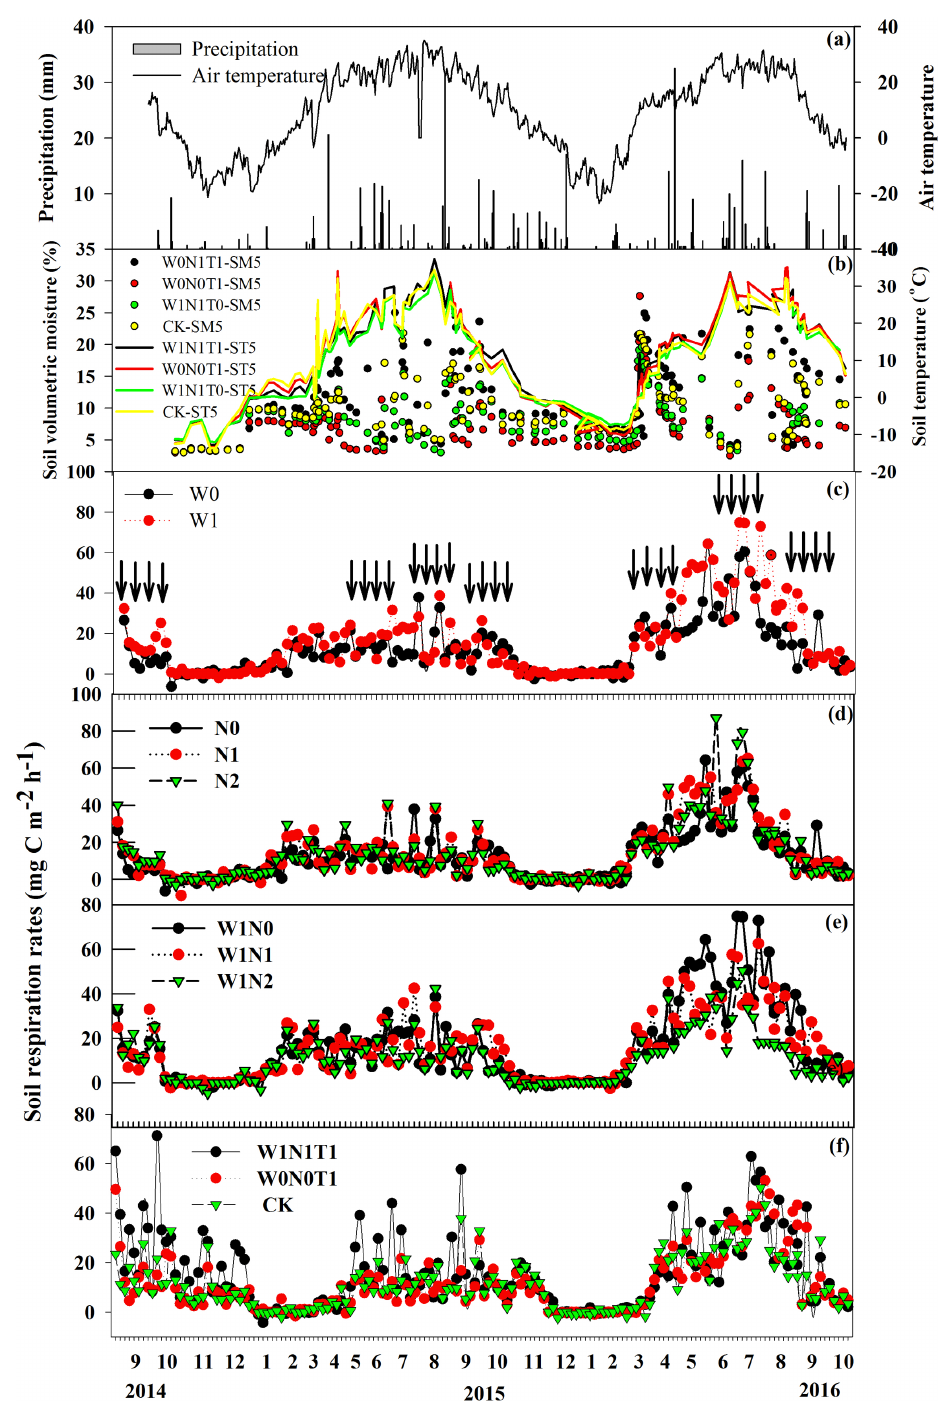
Figure 2. Variation in rainfall (mm, a ), and air temperature ( ◦ C, a ) from September 2014 to October 2016 at the Gurbantunggut Desert. Also shown are soil moisture and temperature responses to increasing precipitation and warming (b) , and the response of R s (mean, n = 4) to precipitation (c) , N deposition (d, e) and warming (f) . W0 and W1 indicate under ambient precipitation (without water addition) and 60mmyr − 1 precipitation addition; N0, N1 and N2 indicate 0, 30 and 60kgNha − 1 yr − 1 nitrogen addition; W1N0, W1N1 and W1N2 indicate 0, 30 and 60kgNha − 1 yr − 1 nitrogen addition under 60mmyr − 1 precipitation addition; W1N1T1, W0N0T1 and W0N0T0 indicate the interaction between increasing precipitation (60mmyr − 1 ) , N deposition (30kgNha − 1 yr − 1 ) and warming by OTCs, warming alone (without increasing precipitation and N deposition) and control plots, respectively. Black arrows indicate simulated precipitation (5mm) and N deposition (0.25 or 0.5gNm − 2 ). Each point represents the mean of four replications (chambers). Standard deviations for R s are not shown for figure